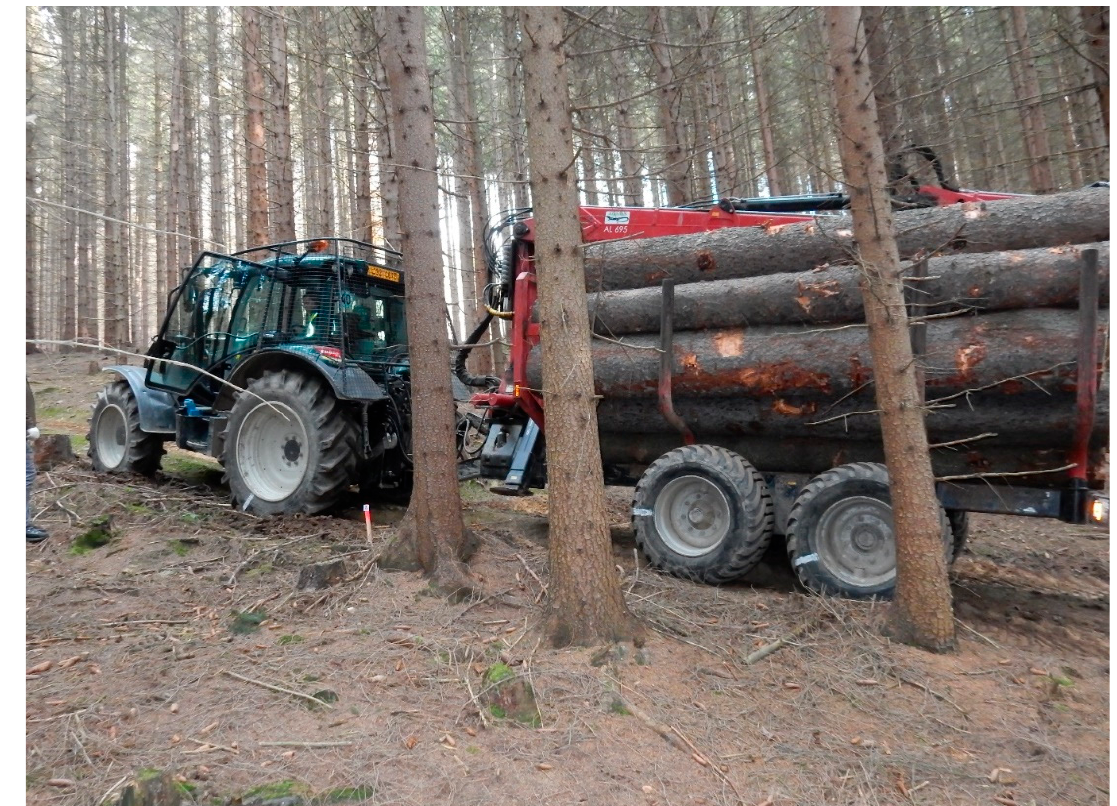
Figure 4. Tractor-trailer unit during tests in forest stands near the village of Nová Ř íše (author: Jind ř ich Neruda).